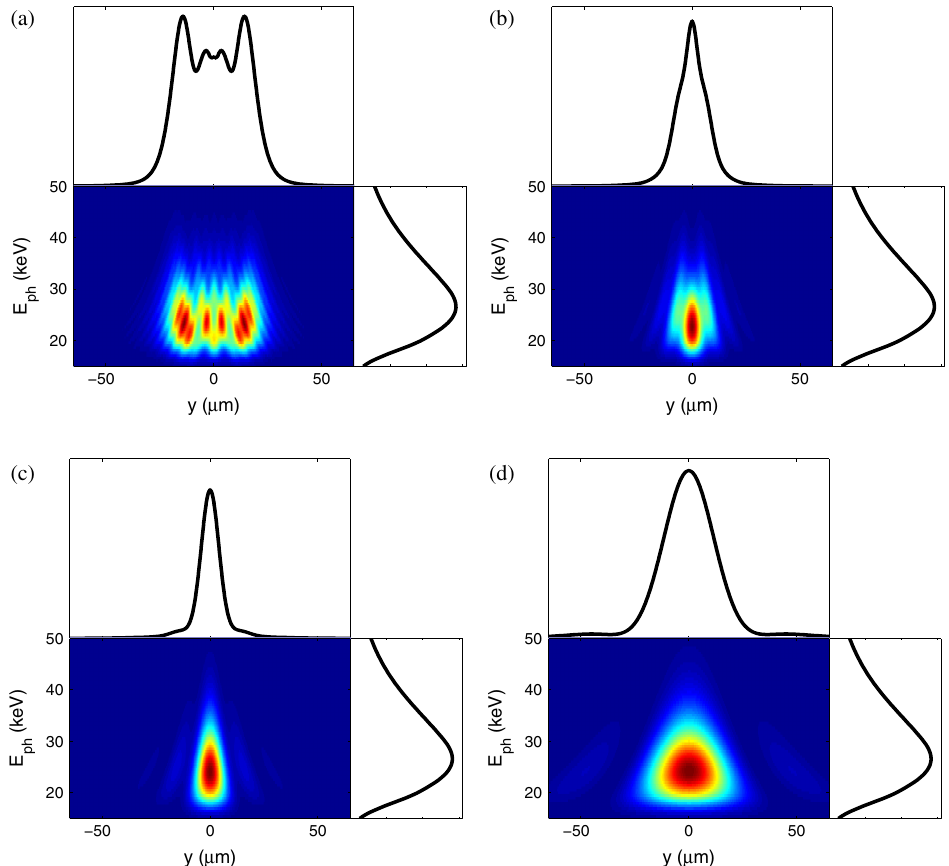
FIG. 9. (Color) Fresnel diffraction of the synchrotron radiation in pinhole 2 through several apertures: 50 (cid:1) m (a), 25 (cid:1) m (b), 15 (cid:1) m (c), and 5 (cid:1) m